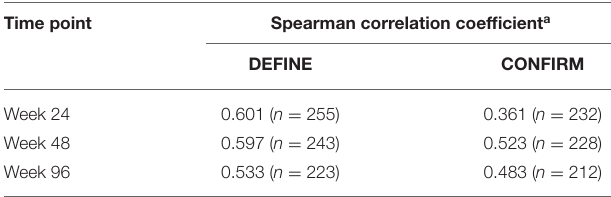
TABLE 2 | Correlations between percentage change from baseline in brain parenchymal fraction and percentage brain volume change from baseline for each study time point, by